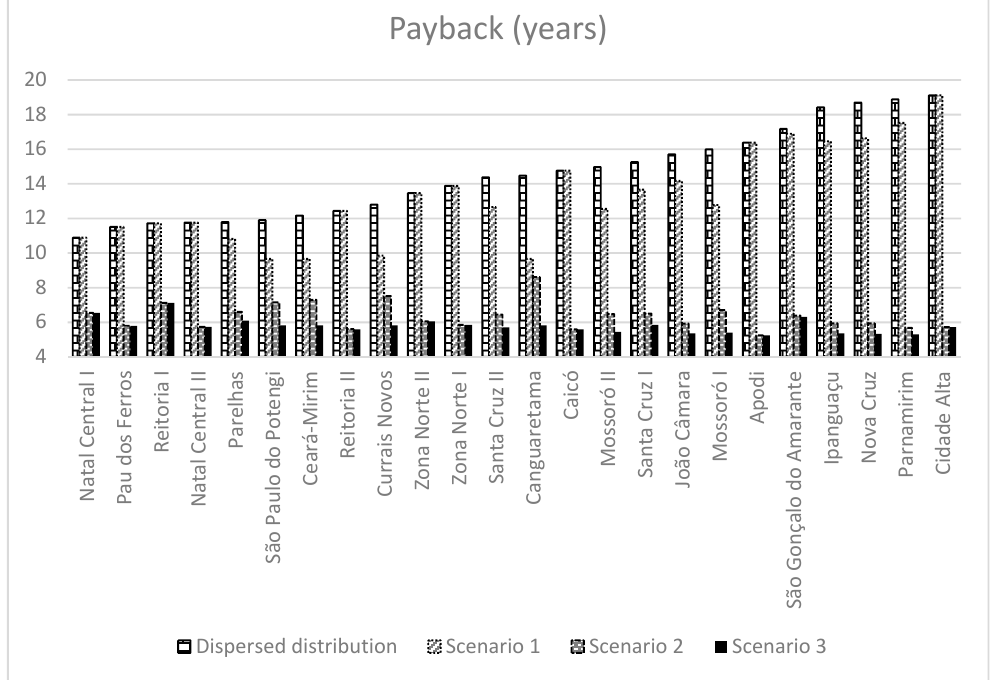
Figure 8. Payback behavior of the IFRN Solar distribution project considering dispersed plant distribution and Scenarios 1, 2, and 3.